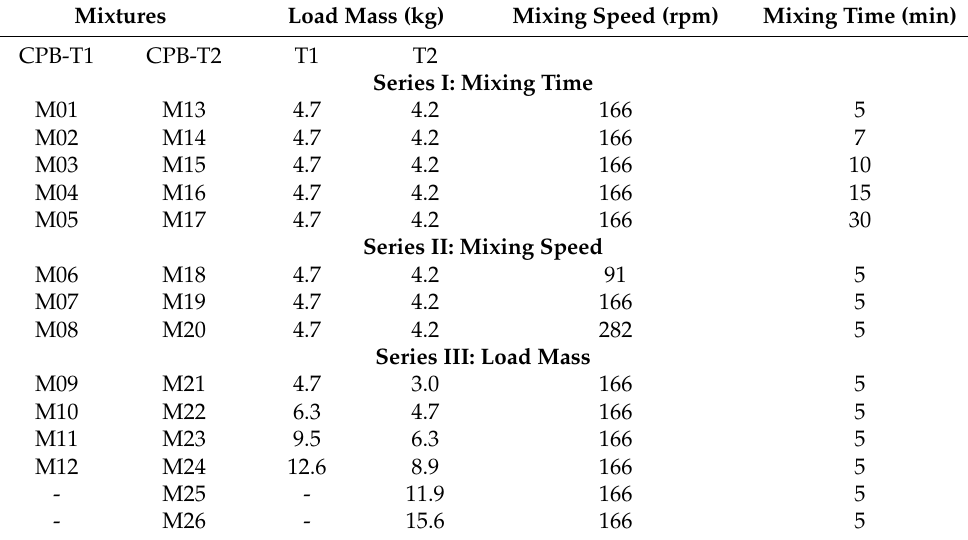
Table 5. CPB mixtures used to investigate the influence of mixing parameters on SME and CPB properties. Mixtures Load Mass (kg) Mixing Speed (rpm) Mixing Time (min)